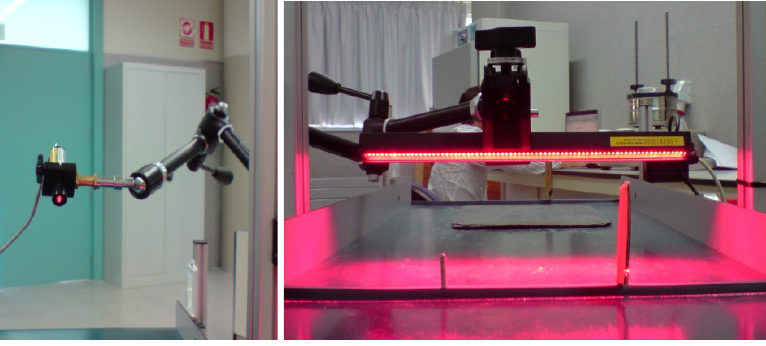
Figure 3. Lighting systems used: A laser unit for 3D (left) and red light unit for 2D (right).